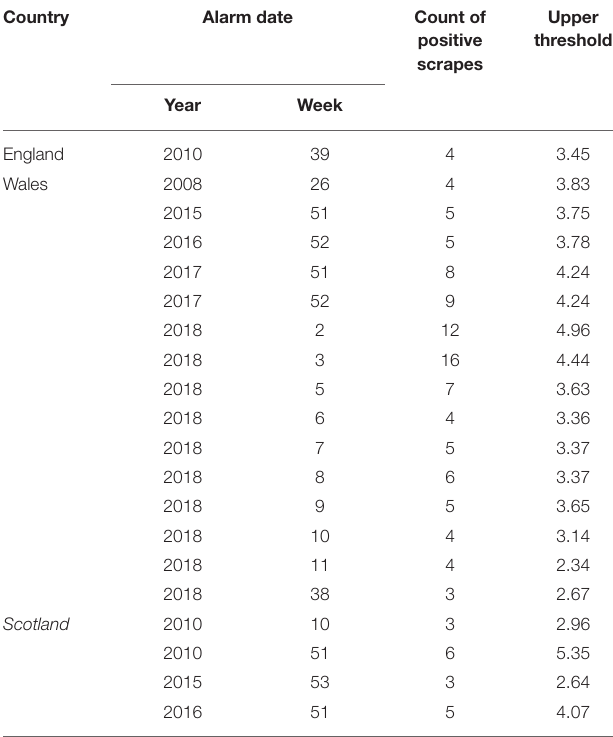
TABLE 3 | Alarms raised by the Farrington algorithm applied to England, Wales and Scotland.